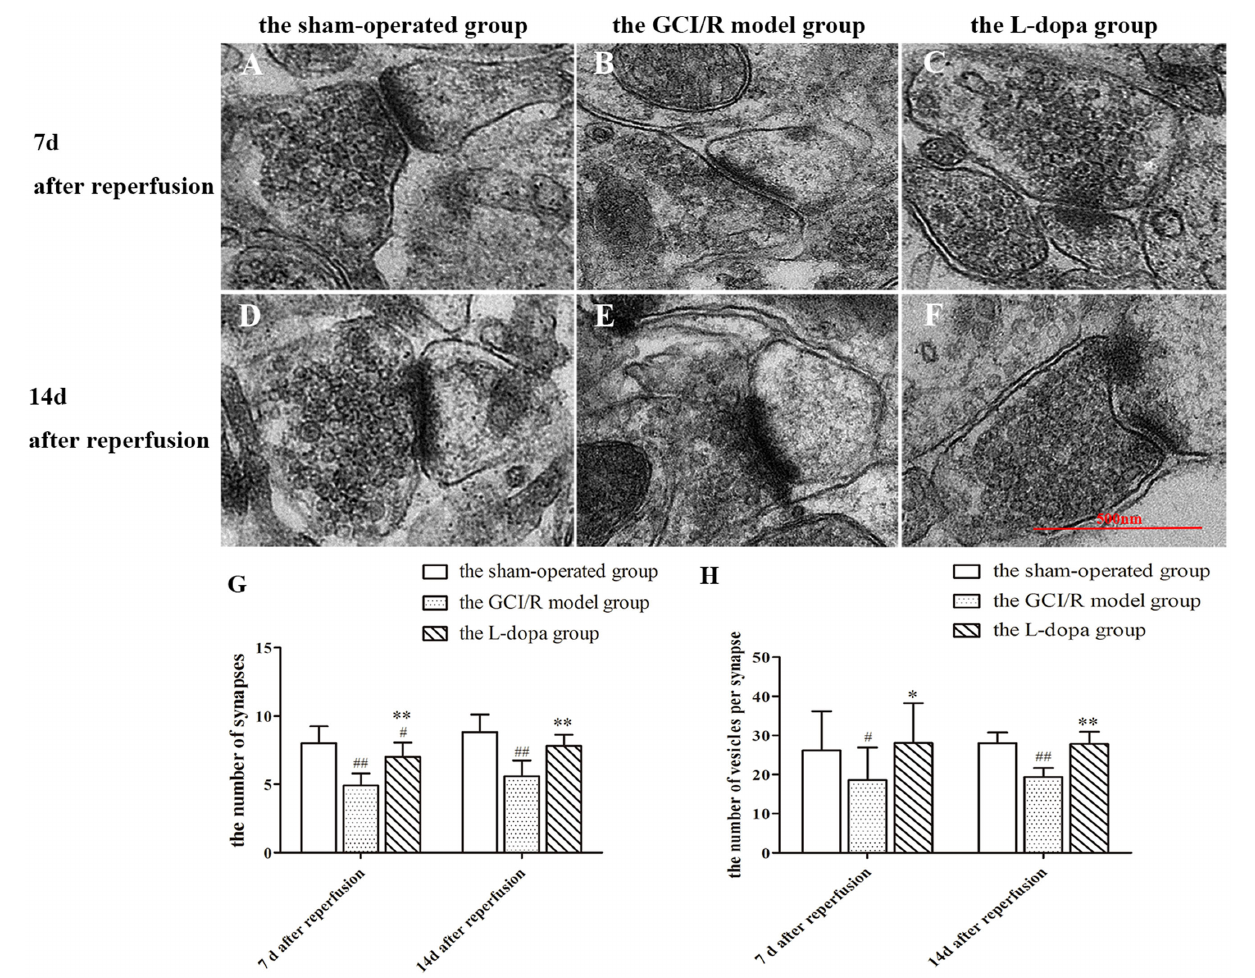
FIGURE 7 | Ultrastructure of synapses in hippocampus. (A–F) Representative section for synaptic ultrastructure at 7 and 14 days after GCI/R injury. Scale bar 500 µ m for Magnification 20,000 × . (G) The number of synapses in hippocampal CA1. Magnification 6,000 × . (H) The number of vesicles per synapse in hippocampal CA1. Data are shown as means ± SD. ## p < 0.01 vs. the sham-operated group, ** p < 0.01 vs. the GCI/R model group. # p < 0.05 vs. the sham-operated group, * p < 0.05 vs. the GCI/R model group.